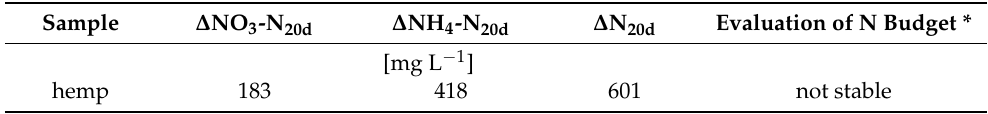
Table 2. Investigation of nitrogen immobilization of hemp substrates according to the VDLUFA method.